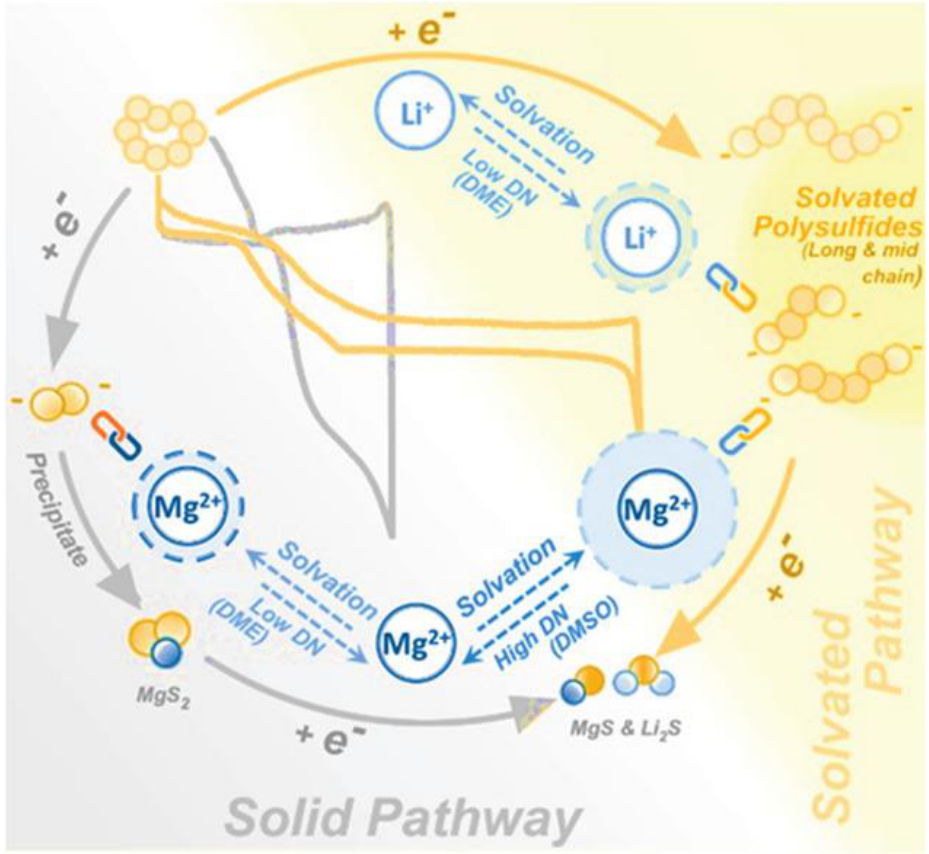
Figure 3. Schematic illustration of sulfur reduction reactions in the Li–S and Mg–S cells. Taken from [28].